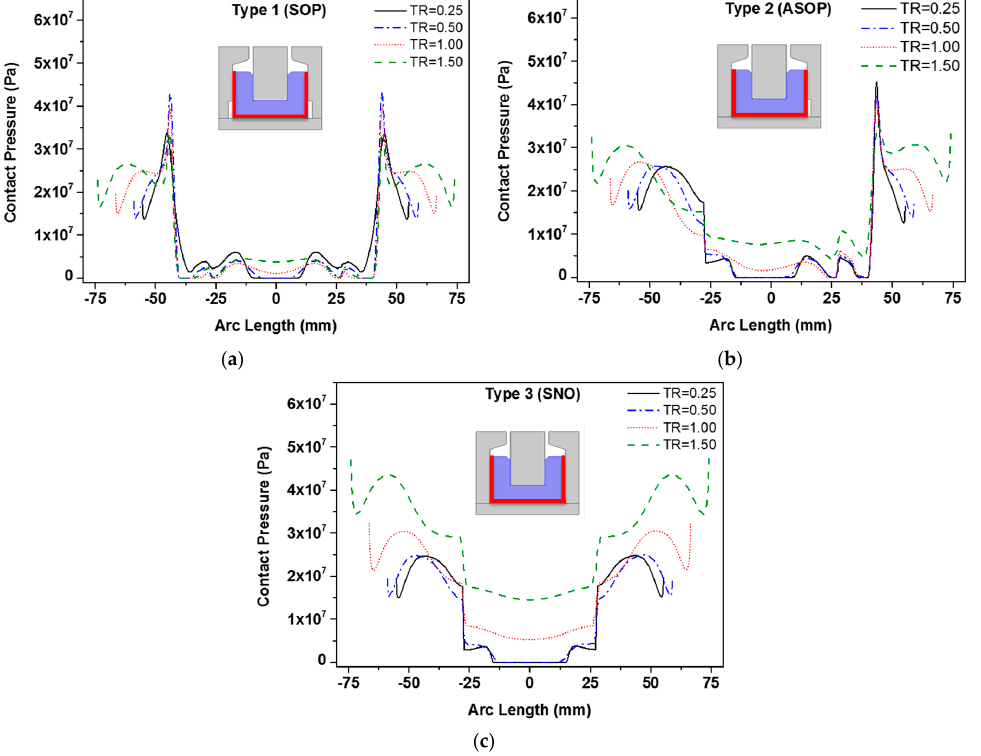
Figure 5. Contact-pressure distributions along the interface between the outer area of the UMS and the surrounding area at 40% of the axial compression in assembly: ( a ) type 1; ( b ) type 2; and ( c ) type 3. SOP: symmetric open groove; ASOP: asymmetric open groove; SNO: symmetric no groove.